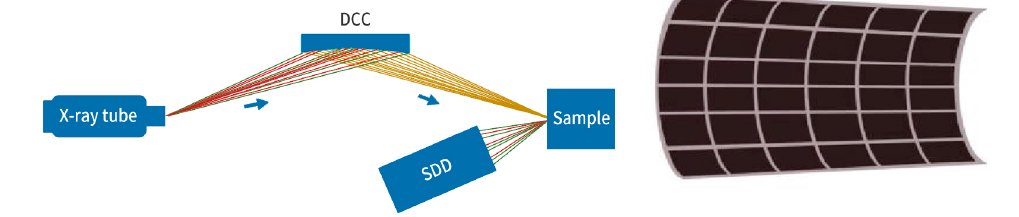
Figure 1. Optical schematic diagram of MED-XRF and DCC for monochromatization and focusing of the X-ray.